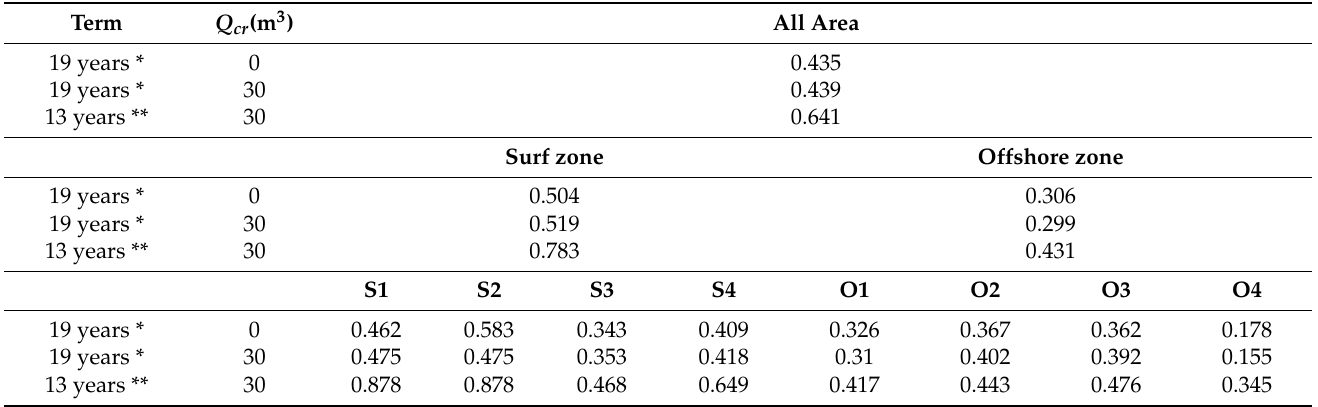
Table 2. Correlation of sediment volume change and cumulative river discharge for the entire area, surf zone and offshore zone, and each of the eight